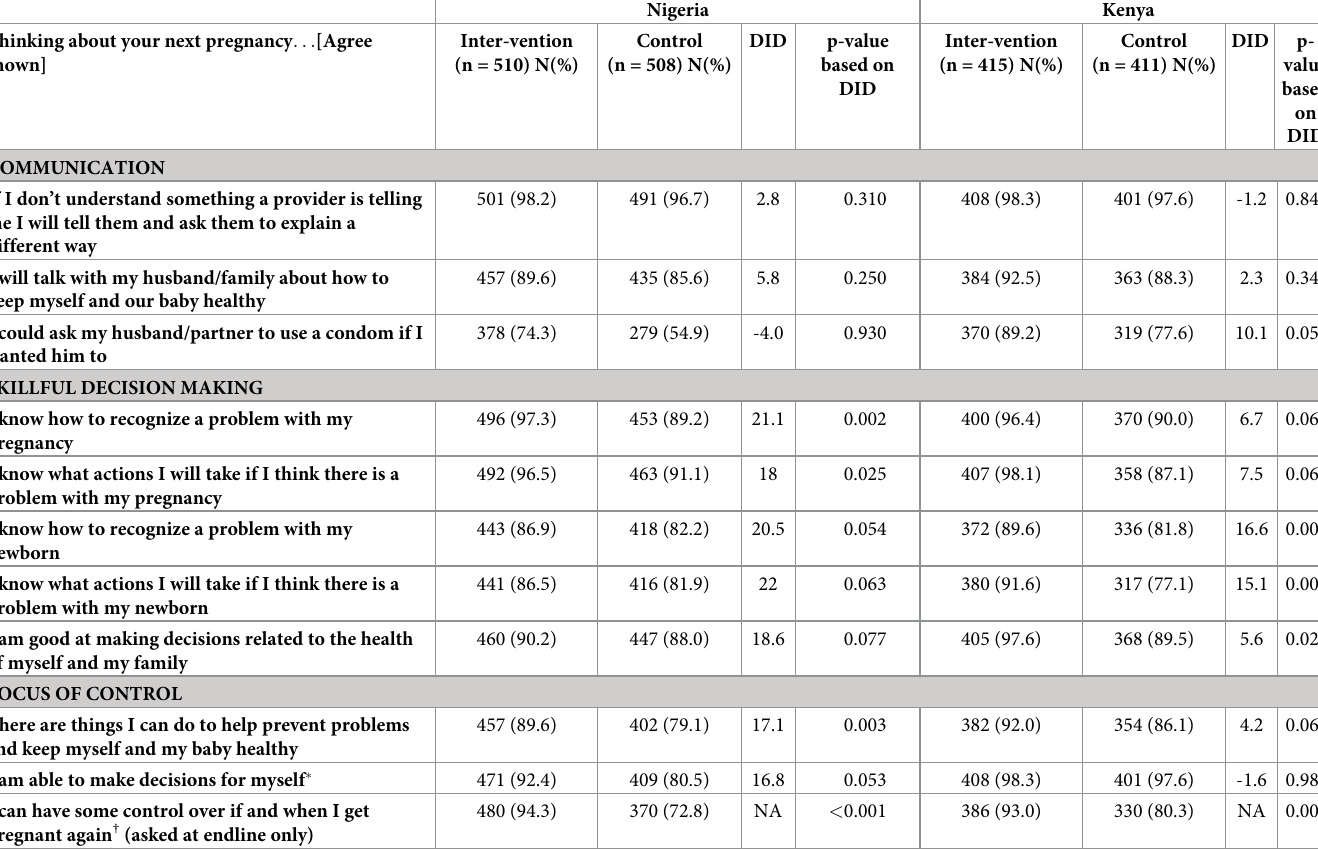
Table 6. Confidence in relation to communication, skillful decision making, and locus of control related to maternal, newborn, and reproductive health. Thinking about your next pregnancy ... [Agree shown]